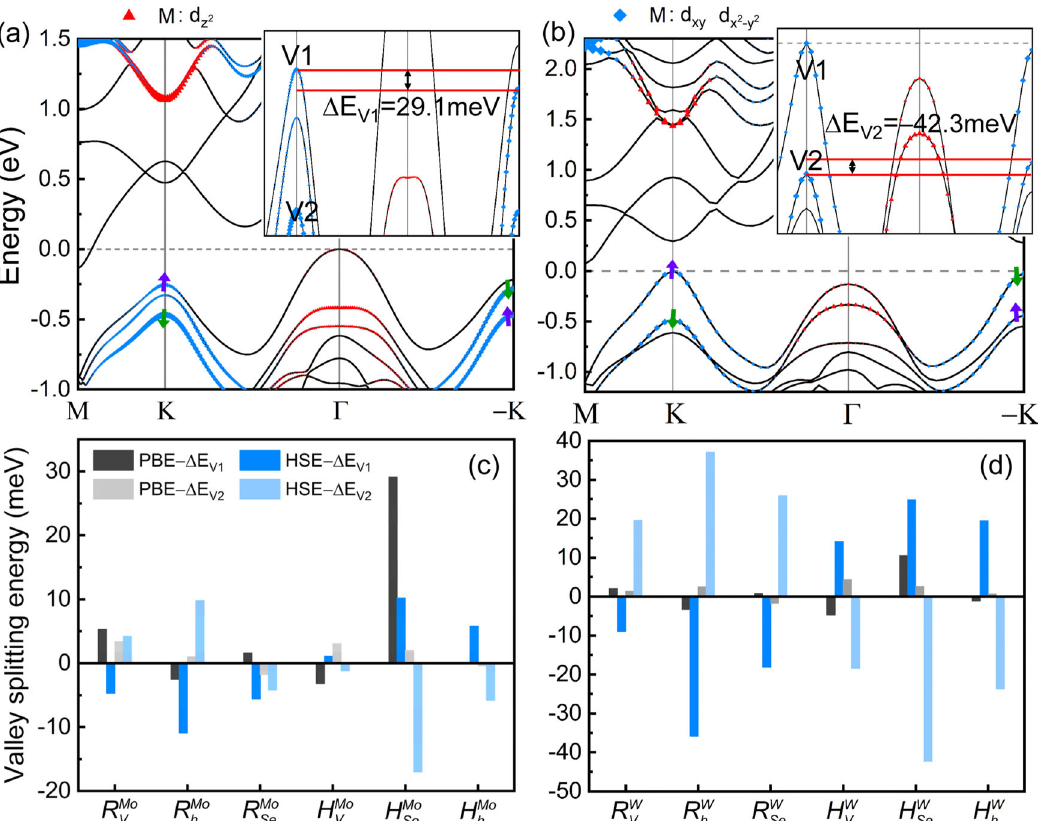
Fig. 3 Electronic band structures and valley splittings of MSe 2 /VSe 2 heterostructures. Orbital projected band structures for H M MoSe 2 /VSe 2 under PBE ( a ) and WSe 2 /VSe 2 under HSE ( α = 0.1, μ = 0.2 Å − 1 ) ( b ) levels, where red triangle represents d z 2 while blue rectangle corresponds to both d xy and d x 2 (cid:2) y 2 orbitals of Mo or W atoms. The green and purple arrows denote the spin-down and spin-up bands of monolayer MSe 2 , respectively. Inset: Enlarged details of the valley splitting in the topmost valence band Δ E V1 in ( a ) and the second topmost valence band Δ E V2 in ( b ). Valley valence band splittings for different stackings of MoSe 2 /VSe 2 ( c ) and WSe 2 /VSe 2 ( d ) from both PBE and HSE